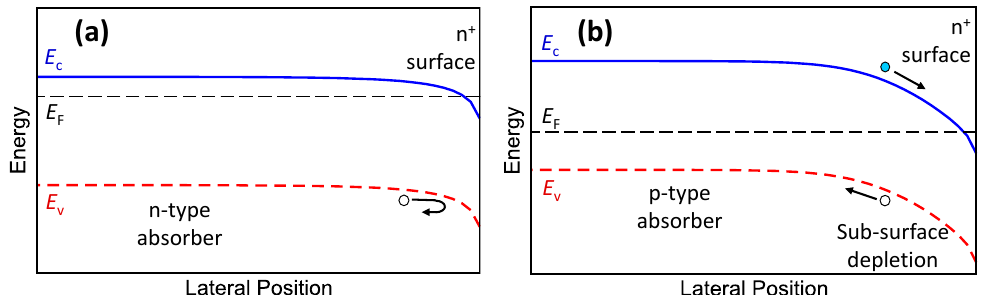
Figure 3 . Energy band diagram illustrating band bending near the sidewall surface of ( a ) an n-type, and ( b ) a p-type InAs/InAsSb T2SLS. The surface is degenerate n-type in both cases.